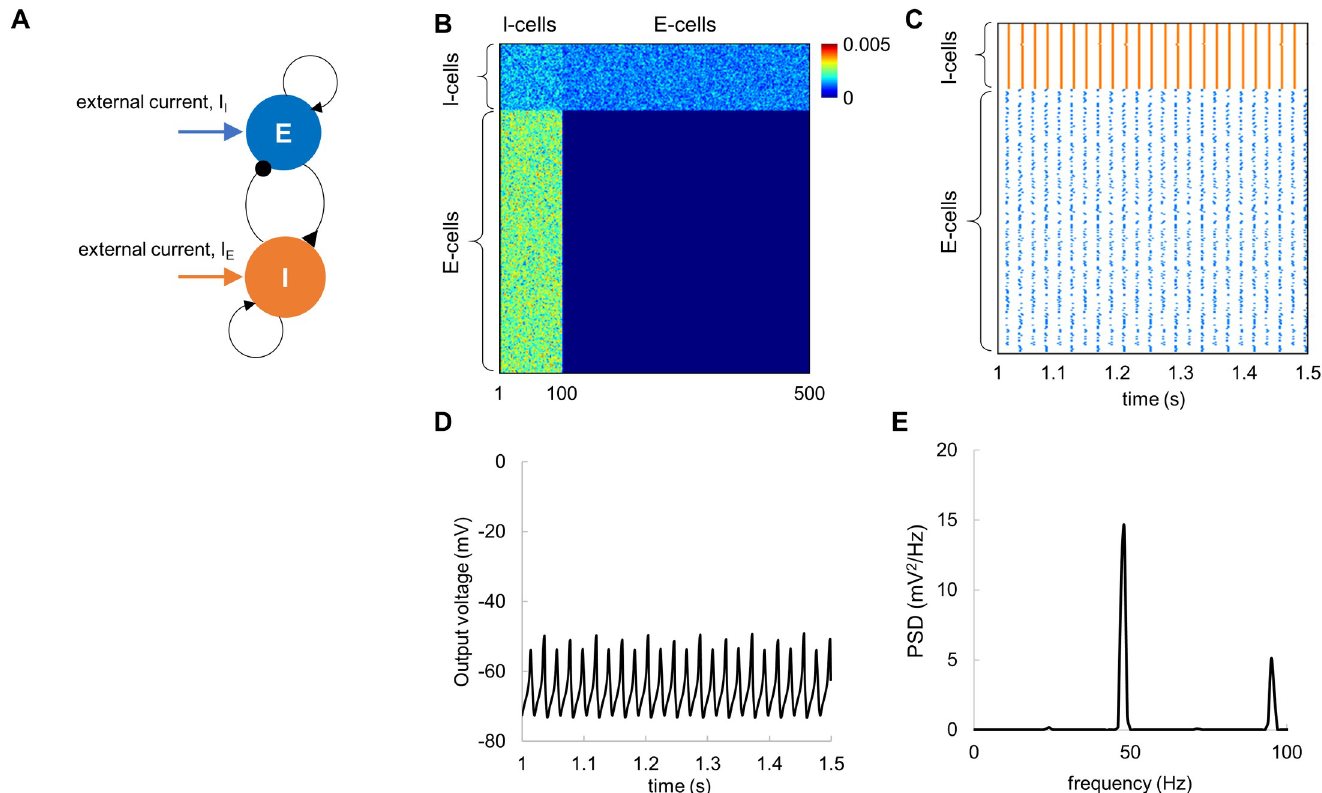
Fig 5. The PING model with constant input currents produces robust neuronal oscillations at around 48 Hz. (A) Neuronal architecture; the simulated network consisted of interconnected E-cells (N = 400) and I-cells (N = 100). (B) Connectivity matrix between E-cells and I-cells. (C) Spike rastergram for E-cells (blue) and I- cells (orange) shows temporal synchronization among the cells in the presence of constant input current. (D) The average membrane potential of the E-cells exhibited prominent oscillations. (E) Power spectral density of the average membrane potential for the E-cells shows a clear peak at 48 Hz. Note that PSD was averaged over 20